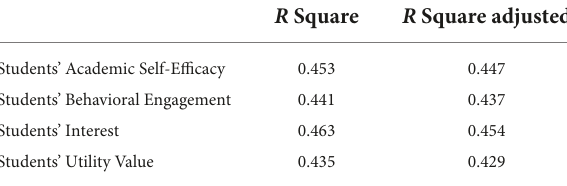
TABLE 7 Coefficient of determination ( R